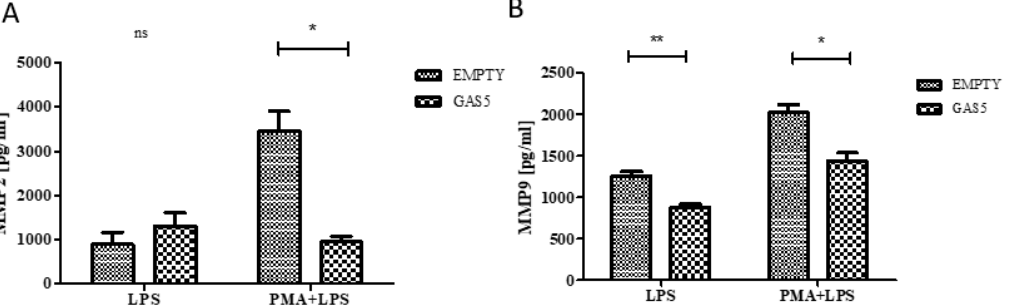
Figure 8. Evaluation of levels of MMP2 (A) and MMP9 (B) after overexpression of GAS5 (GAS5) in monocyte stimulated with LPS (LPS) and macrophages stimulated with LPS (PMA + LPS) and control (EMPTY). Two-way ANOVA: EMPTY vs. GAS5 MMP2 p = 0.02, MMP9 p < 0.0001 Bonferroni’s multiple comparison post-test * p < 0.05, ** p < 0.01; ns = not significant.